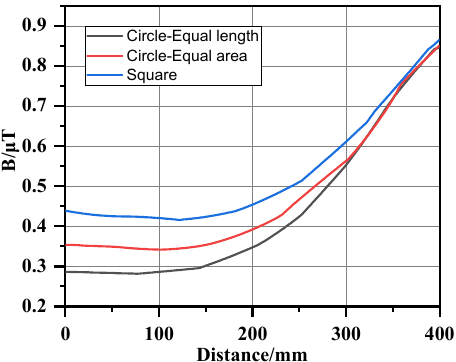
Figure 13. Simulation of the magnetic induction intensity distribution curve in the case of circular and square meshes.